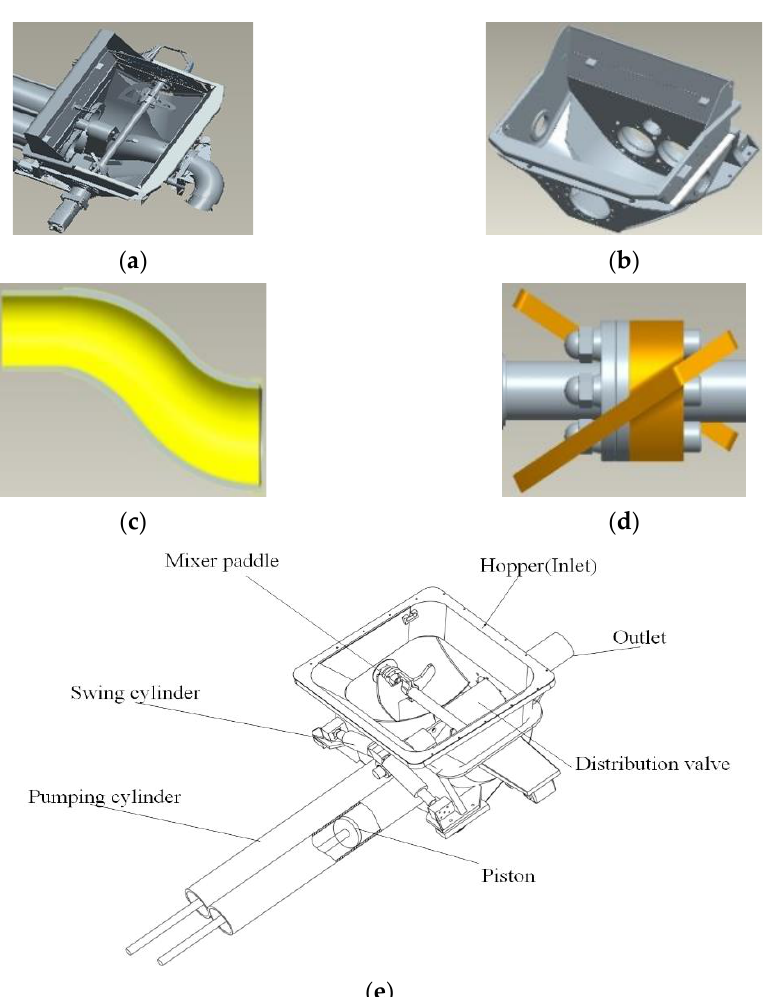
Figure 15. Concrete pumping machinery. ( a ) Concrete pumping assembly. ( b ) Hopper. ( c ) Distribution valve. ( d ) Mixer paddle. ( e ) Schematic of concrete machinery.